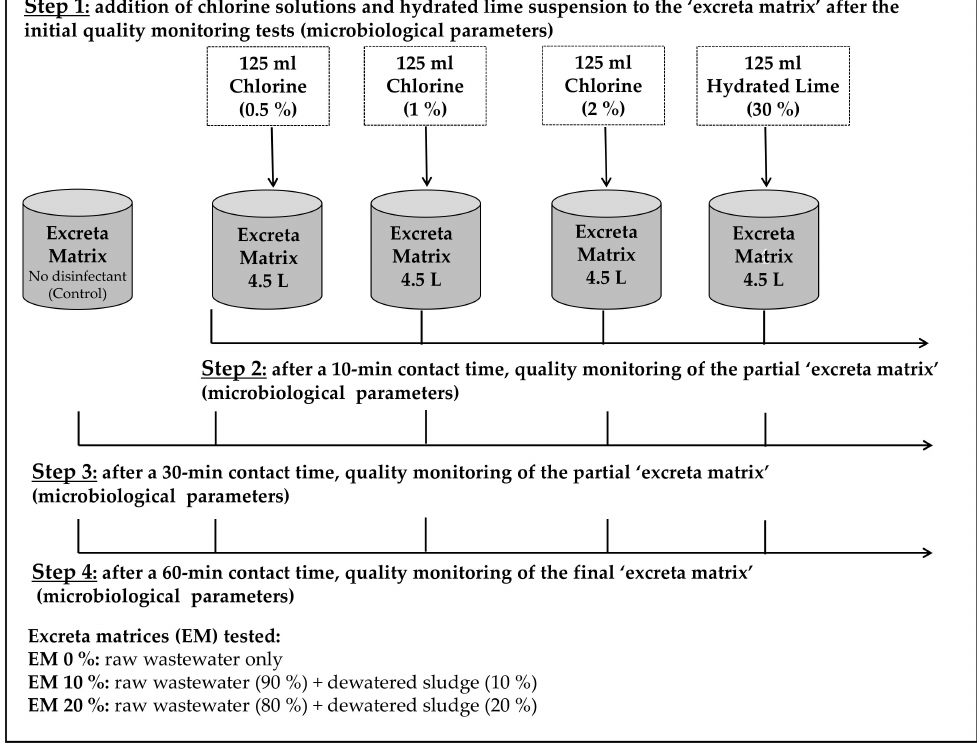
Figure 1. Flow chart of human excreta containment